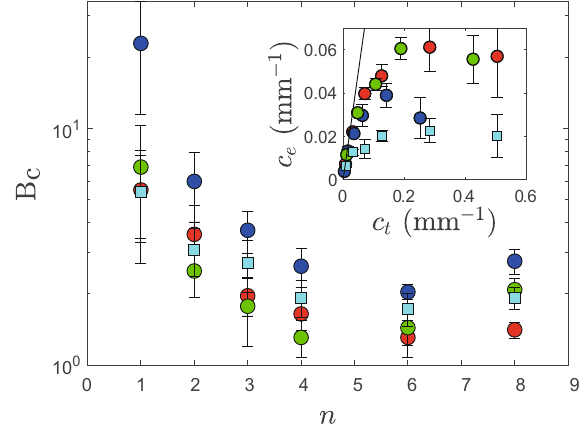
Figure 6. Bingham capillary number B c as a function of the number of printed oscillations for several 5 Pa for blue, red, and green circles with α magnitudes of gradients and yield-stresses ( σ y ≈ 0.5 ). Insert: Experimental final curvature c 2 Pa for the cyan square with α respectively, and σ y = ≈ prescribed one c t ; the solid line has a slope of